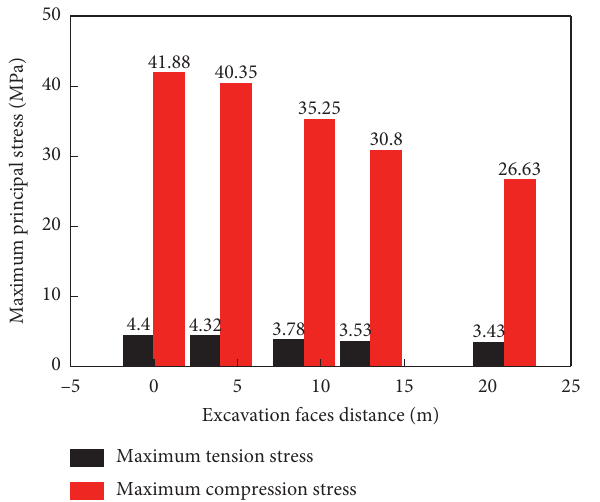
Figure 10: Maximum principal stress of supporting structure of caverns ① and ③ .